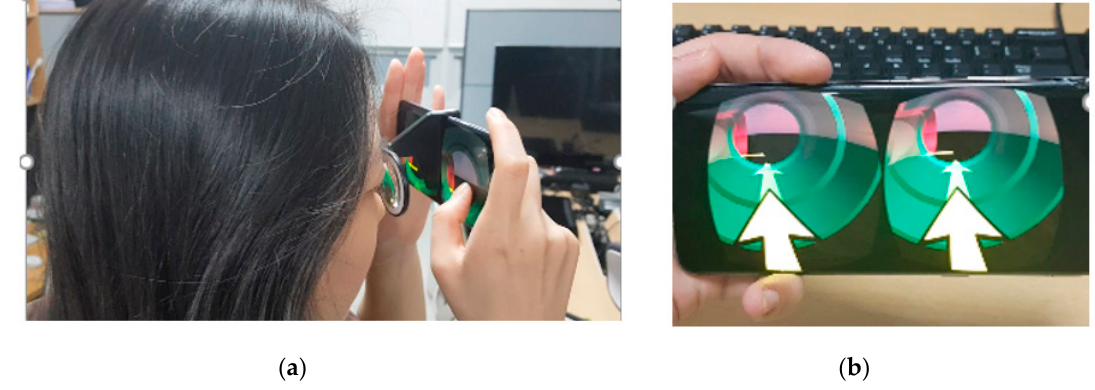
Figure 7. A subject trying out one of the EasyVR navigation methods ( a ) and a capture illustrating what the screen looks like during the tunnel navigation task ( b ).